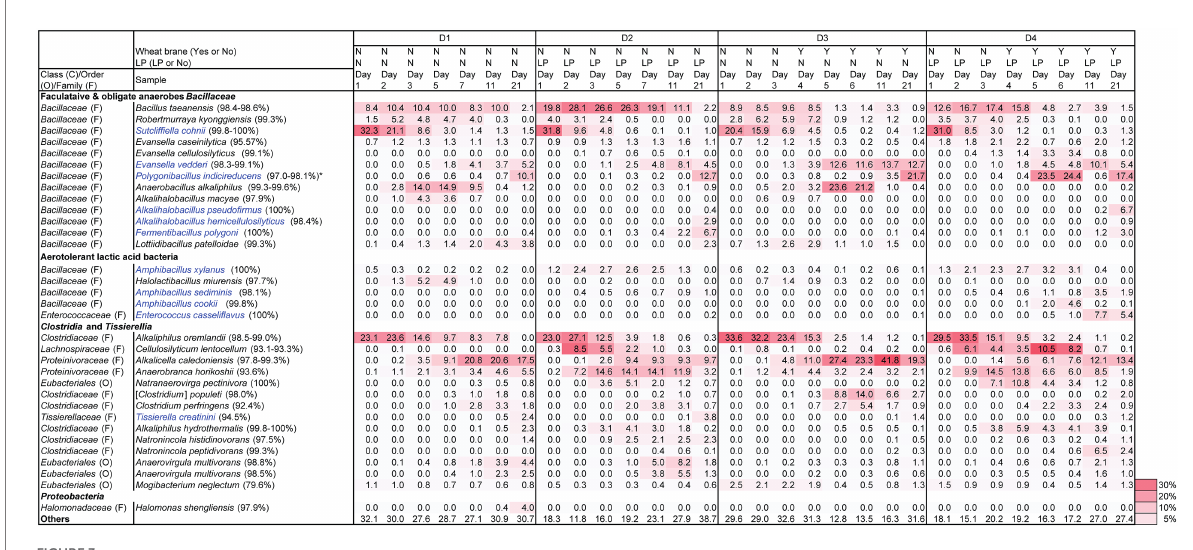
FIGURE 3 Changes in the relative abundance of bacterial communities ( ≥ 2.0% in any sample) depending on the fermentation period in indigo fermentation fluid batches D2 and D4 ( Indigofera tinctoria L. leaf powder [LP] added) and D1 and D3 (controls) and using D- sukumo , based on 16S rRNA analysis. Wheat bran was added to batches D3 and D4 at day 4. Blue letters indicate the confirmed indigo-reducing taxa (including unpublished results). The percentages in the brackets indicate the similarities with the known species in the NCBI database. * Anaerobacillus alkaliphilus -like taxa are involve in Polygonibacillus indicireducens in batch